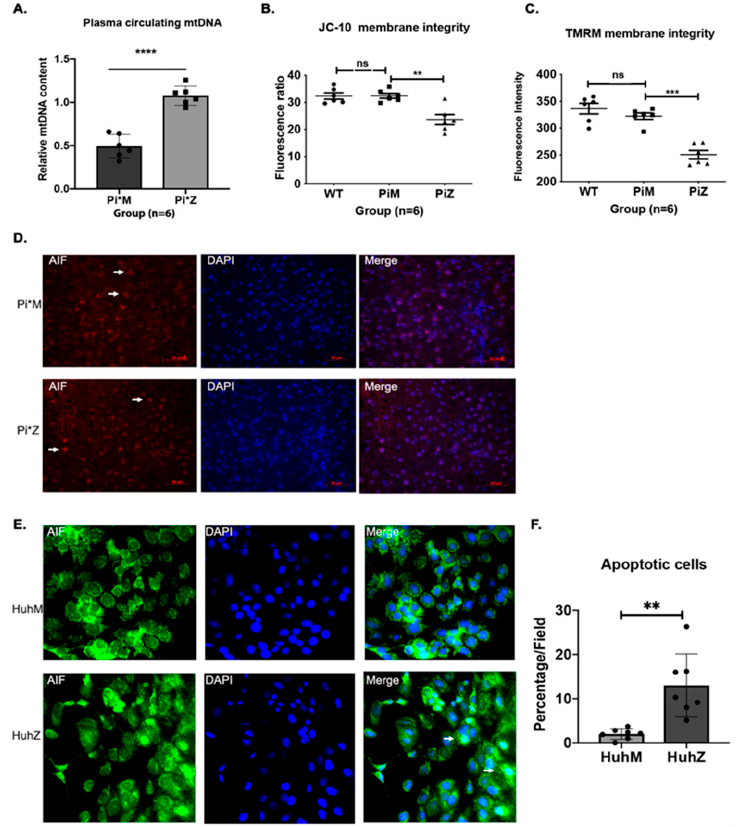
Figure 4. ZAAT-mediated caspase independent apoptosis in hepatocytes. ( A ) Relative mtDNA levels in the plasma of Pi*M and Pi*Z mice, quantified by RT-PCR. ( B ) Mitochondrial membrane integrity measured by JC-10 fluorescence assay in wild-type, Pi*M, and Pi*Z liver homogenates. ( C ) ∆ψΜ levels determined by monitoring fluorescence of tetra-methyl-rhodamine methyl ester (TMRM). ( D ) Immunostaining for endogenous AIF (apoptosis-inducing factor) in Pi*M and Pi*Z mice liver tissue and ( E , F ) in MAAT- and ZAAT-expressing Huh7.5 cells. Arrows show the cytoplasmic localization of AIF in Pi*M mouse liver tissue and nuclear localization of AIF in Pi*Z mouse liver tissue. The bar chart shows the percentage of apoptotic cells in each field of MAAT- and ZAAT-expressing Huh7.5 cells based on nuclear localization of AIF. ns nonsignificant, ** p < 0.001, *** p < 0.0001, **** p < 0.00001. We observed a reduction in JC-10 fluorescence at excitation/emission wavelengths of 490/525 nm and 490/590 nm in Pi*Z liver homogenates compared to Pi*M and wild type